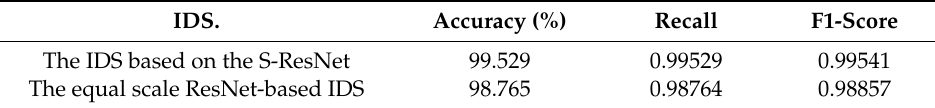
Figure 10. The confusion matrix of the equal scale ResNet-based IDS. Table 3. The comparison results for the two IDSs.